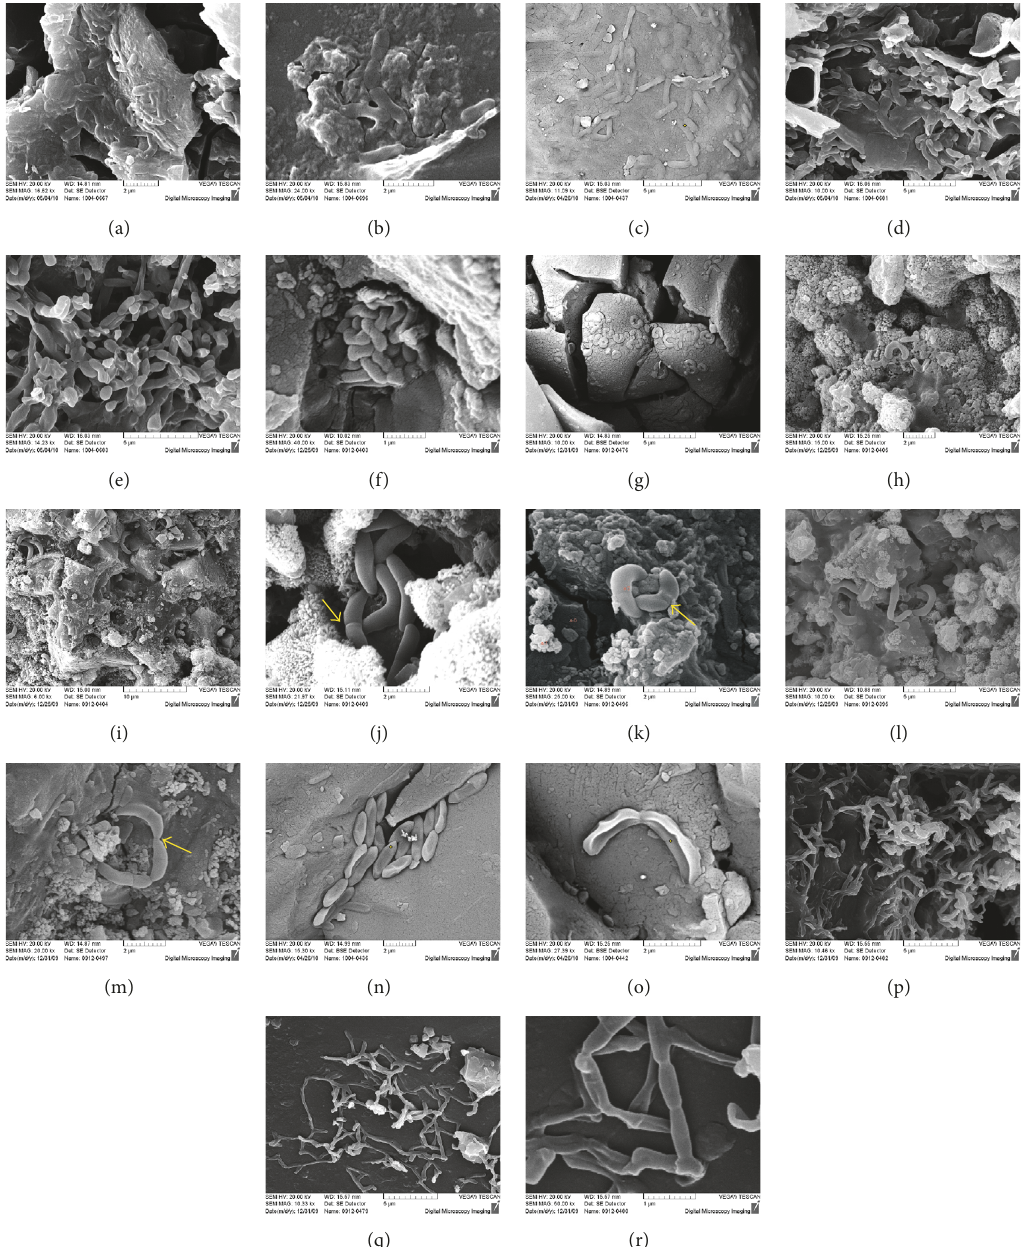
Figure 6: SEM photomicrographs of the rod bacteria fossils and biofilms. EDS data of (a), (b), and (c) were showed in Table 1.